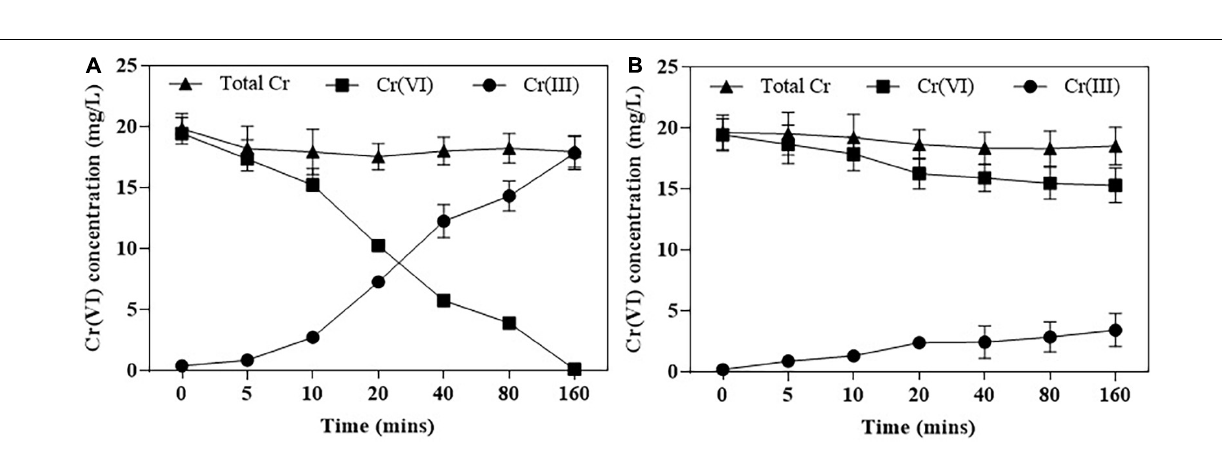
FIGURE 5 | Cr(VI) reduction by purified NR (A) and NiR (B) . Cr(VI) reduction was assayed in Bis-Tris Propane buffer (pH 7.0). Error bars represent standard deviation (SD) from three independent